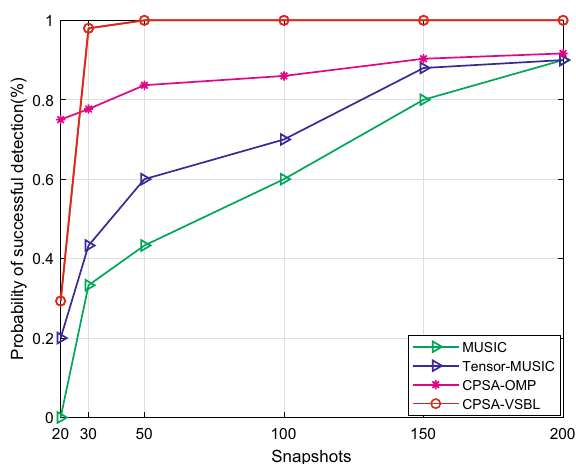
Fig. 10 The probability of successful detection versus number of